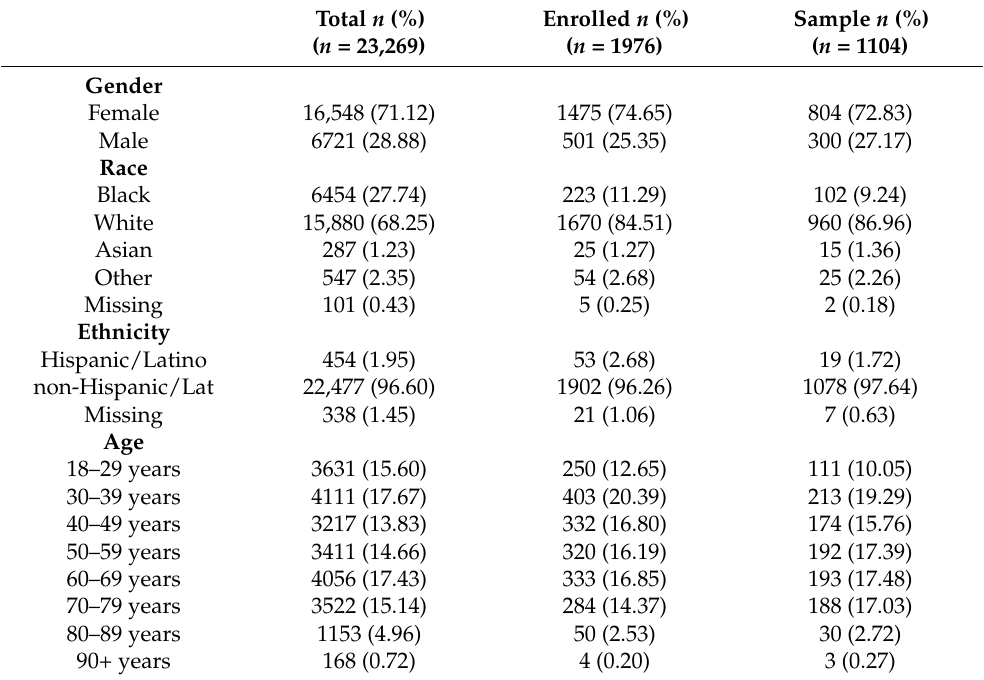
Table 1. Demographic characteristics of patients invited to participate, enrolled, and who provided samples for In Our DNA SC during the pilot